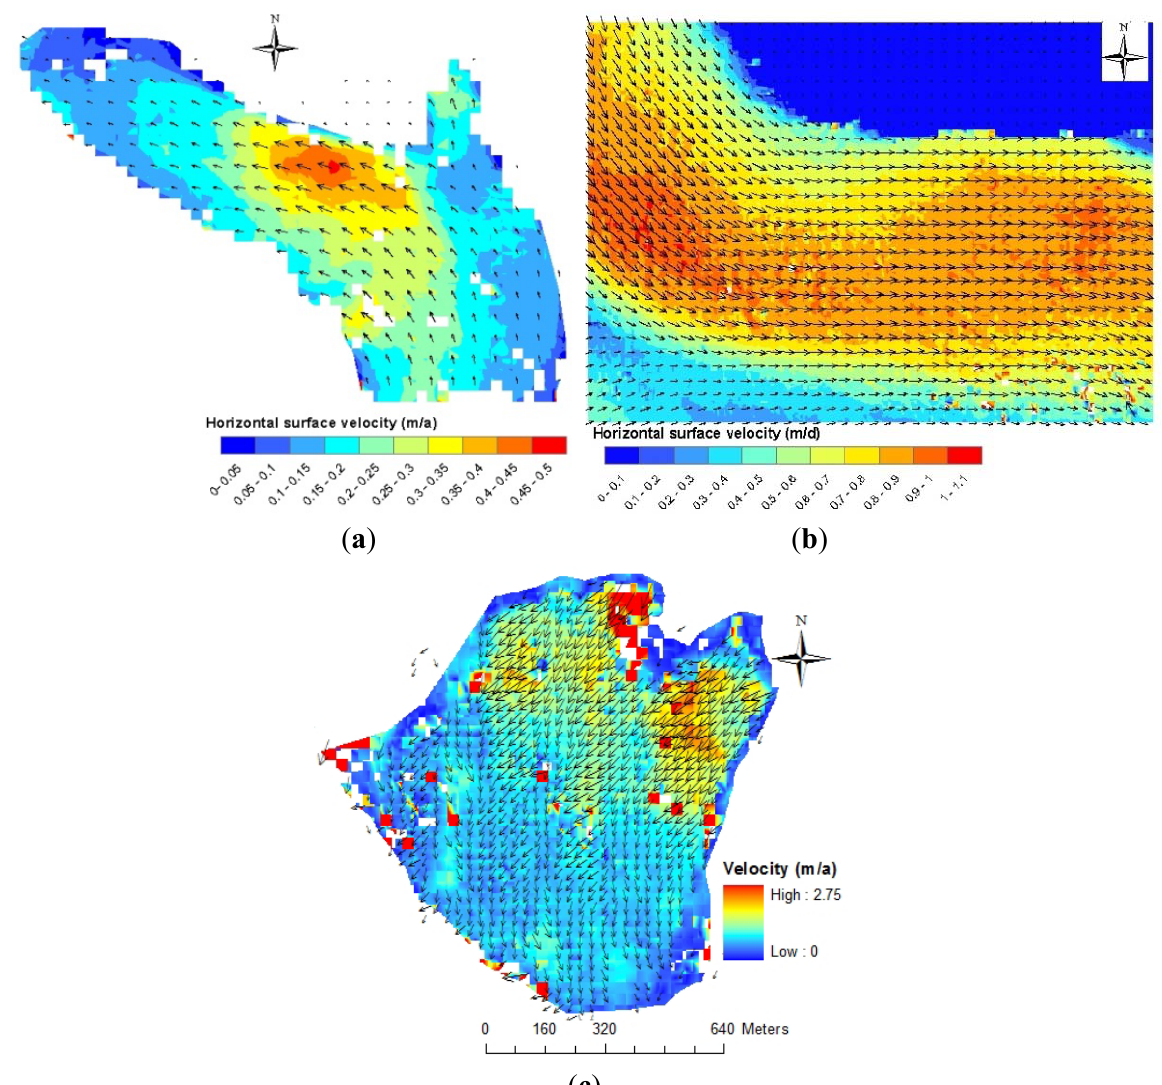
Figure 5. Velocity (ma − 1 ) maps and vectors of ( a ) the Muragl rockglacier, ( b ) the Nigardsbreen glacier and ( c ) the La Clapière landslide computed using the